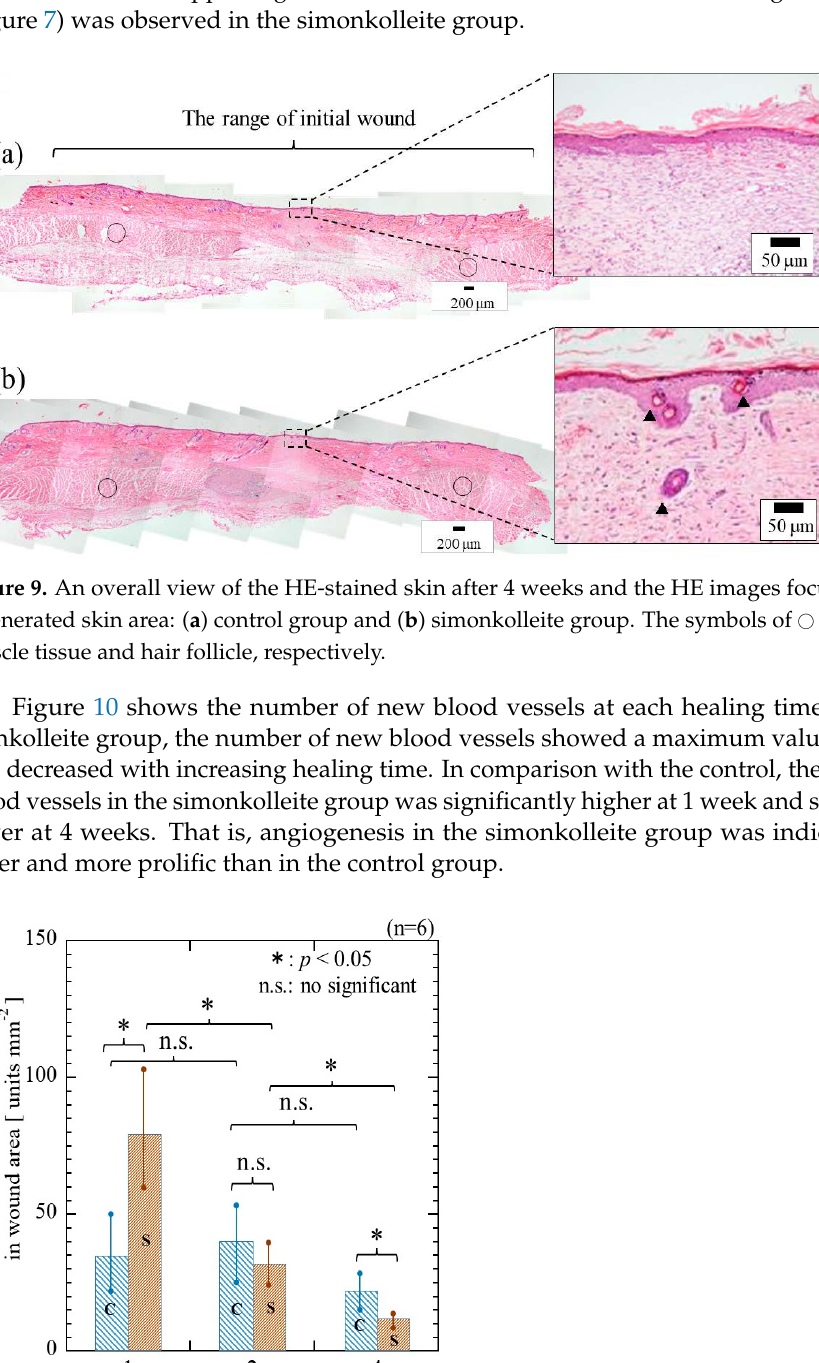
Figure 8. The high magni fi cation images of HE- and MT-stained skin in the wound healing site after ( a ) 1 week, ( b ) 2 weeks, and ( c ) 4 weeks of healing time. ↑ : Angiogenesis; *: Fibroblast; Δ : Granulo- cyte; Λ : Lymphocyte.